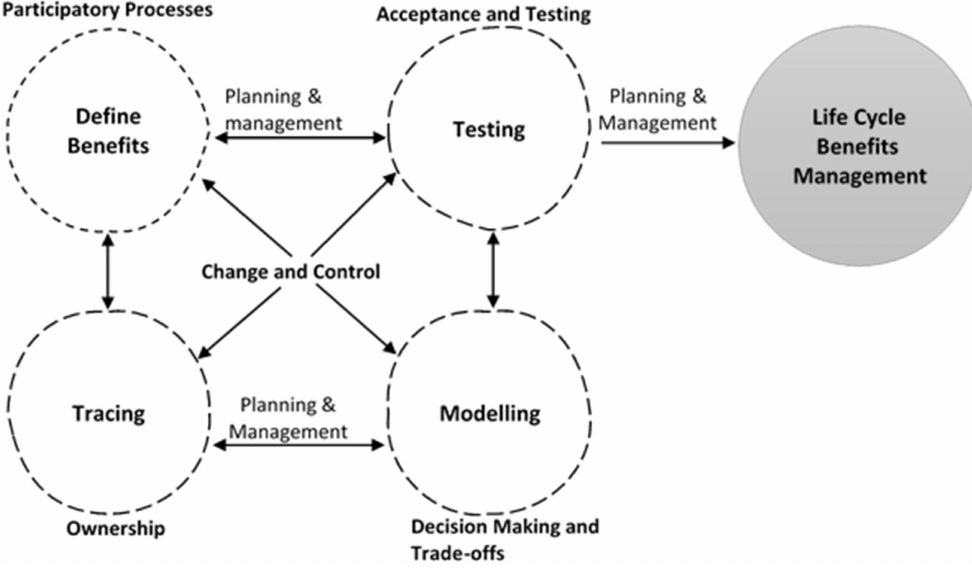
Figure 6. The Change Control Model for requirements management and benefits realisation in an FED